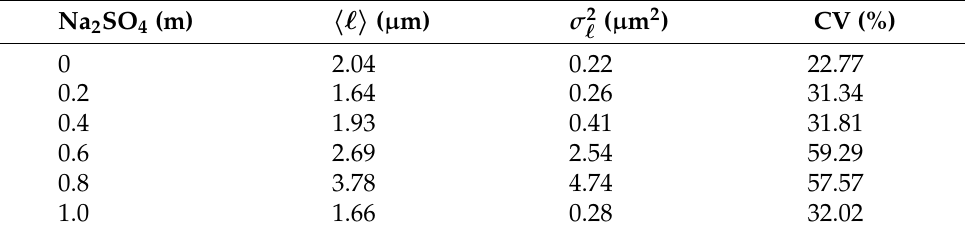
Table 3. Cell length statistics.